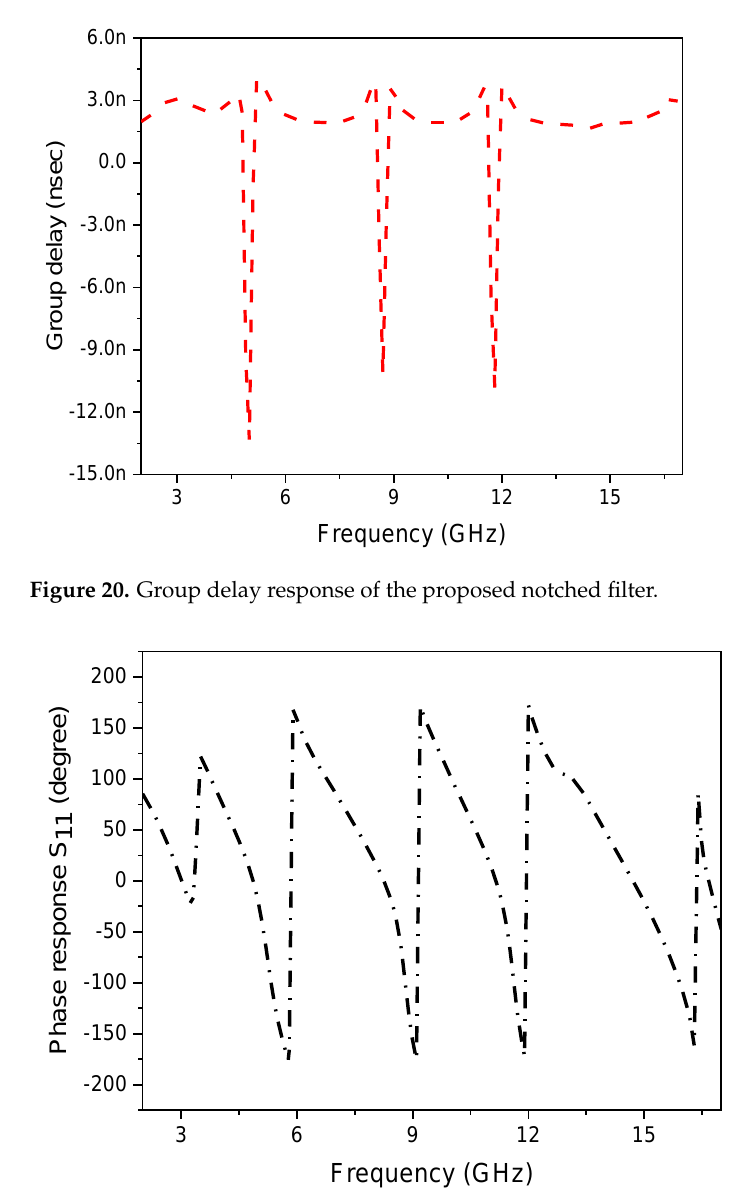
Figure 21. Phase response of the proposed triple-notched filter.